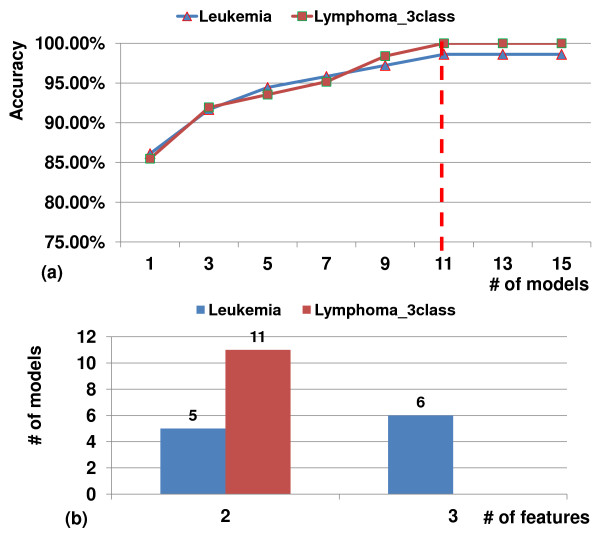
Ensemble statistics.